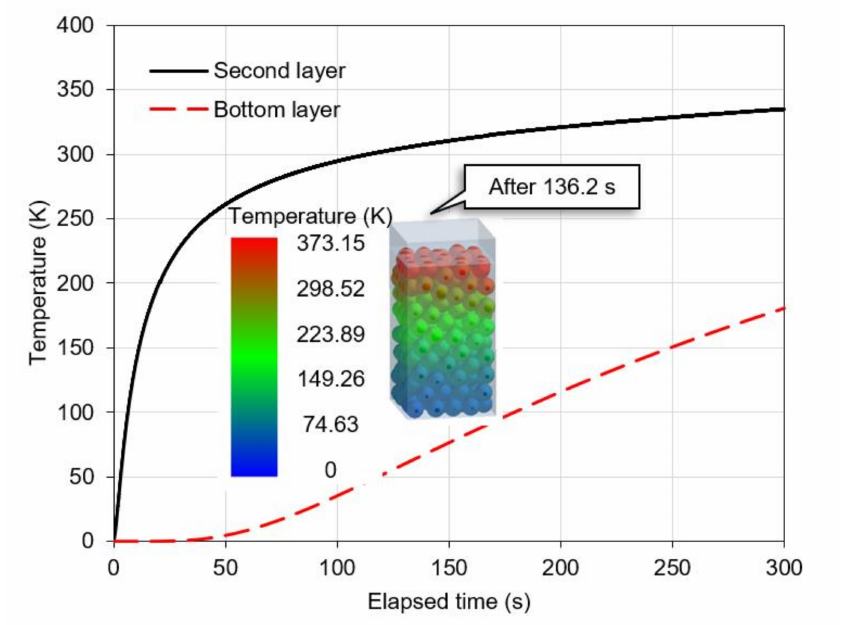
Figure 4. Heat diffusion through the